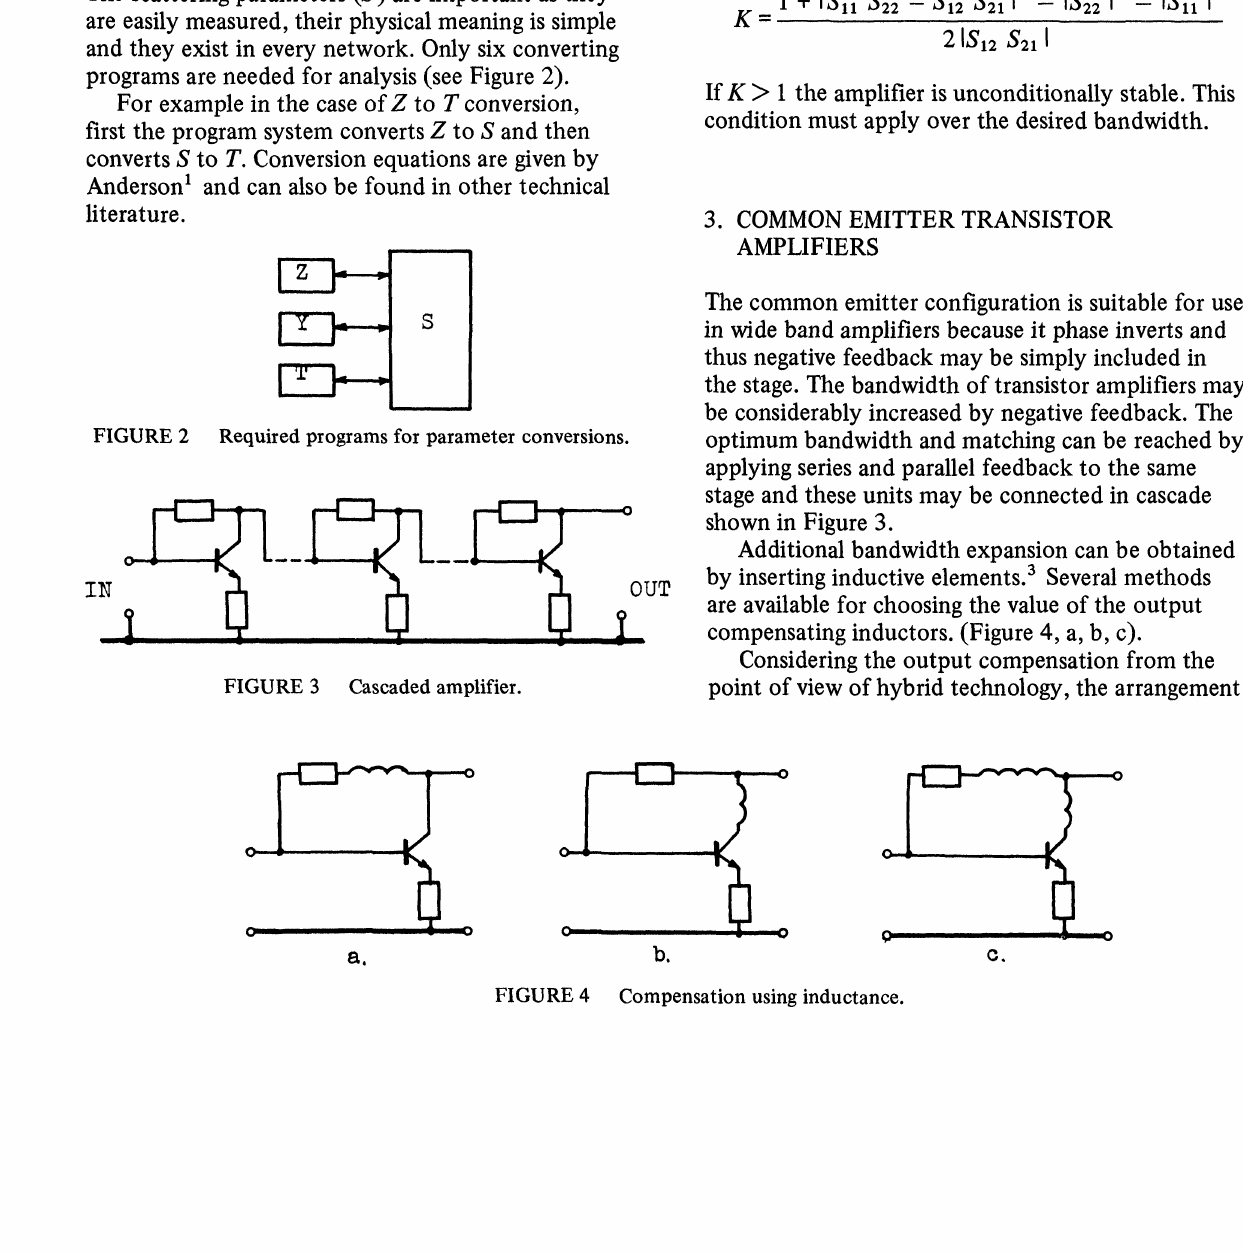
Required programs for parameter conversions.